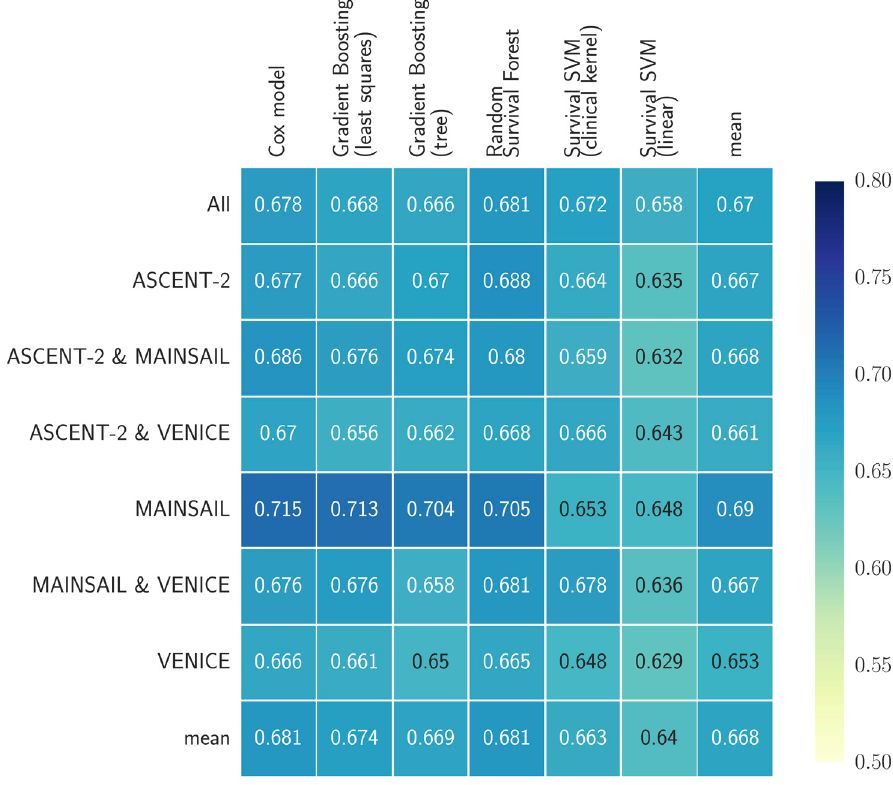
Figure 2. Cross-validation performance of survival models on data from from the ASCENT-2, VENICE, and MAINSAIL trial, as well as any combination of these datasets. The last column (mean) denotes the average performance of all models on a particular dataset and the last row (mean) denotes the average performance of a particular model across all datasets. Numbers indicate the average of Harrell’s concordance index across five cross-validation